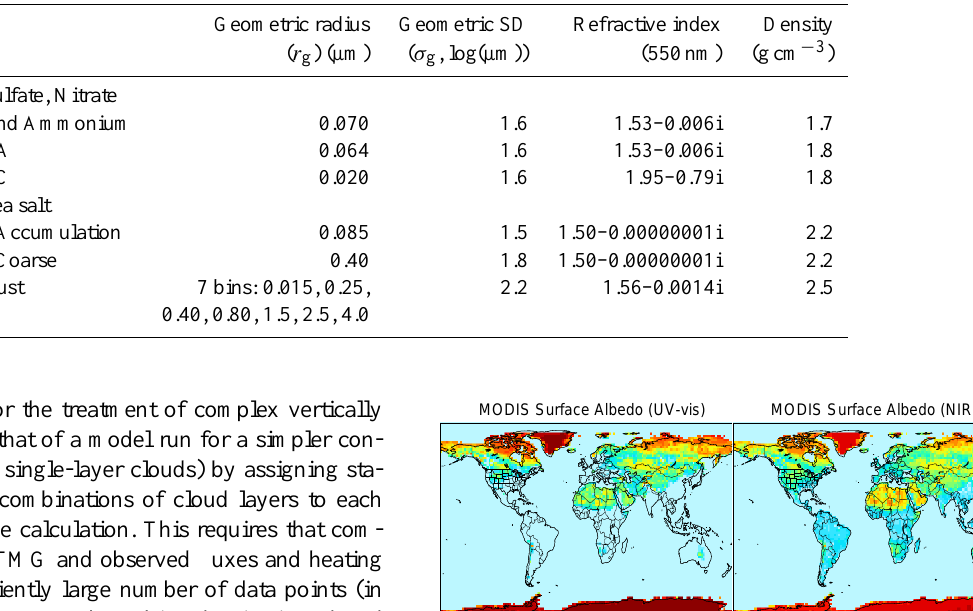
Table 2. GC–RT speciated dry aerosol size and optical properties.